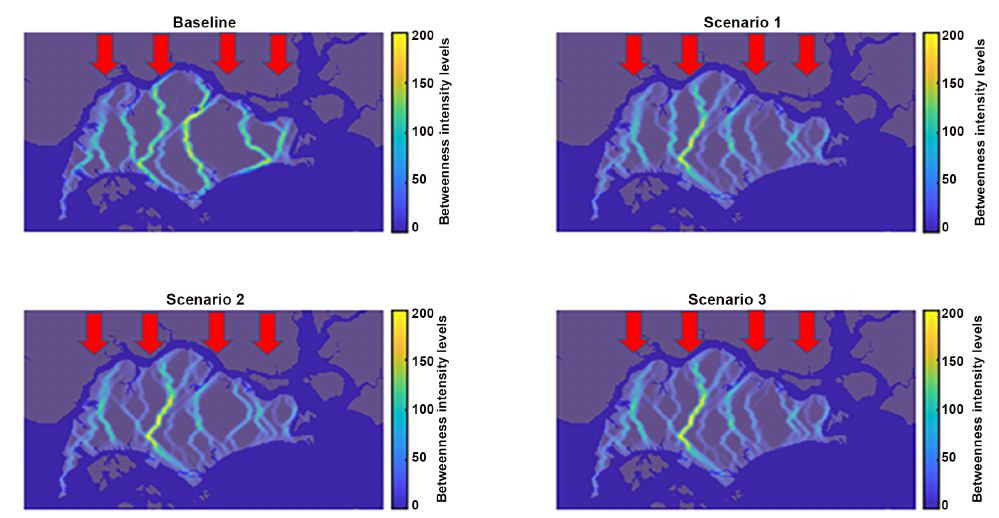
Figure 14. “What-if” scenario: The prevailing wind is North–South, ( θ A = 0), indicated by the red